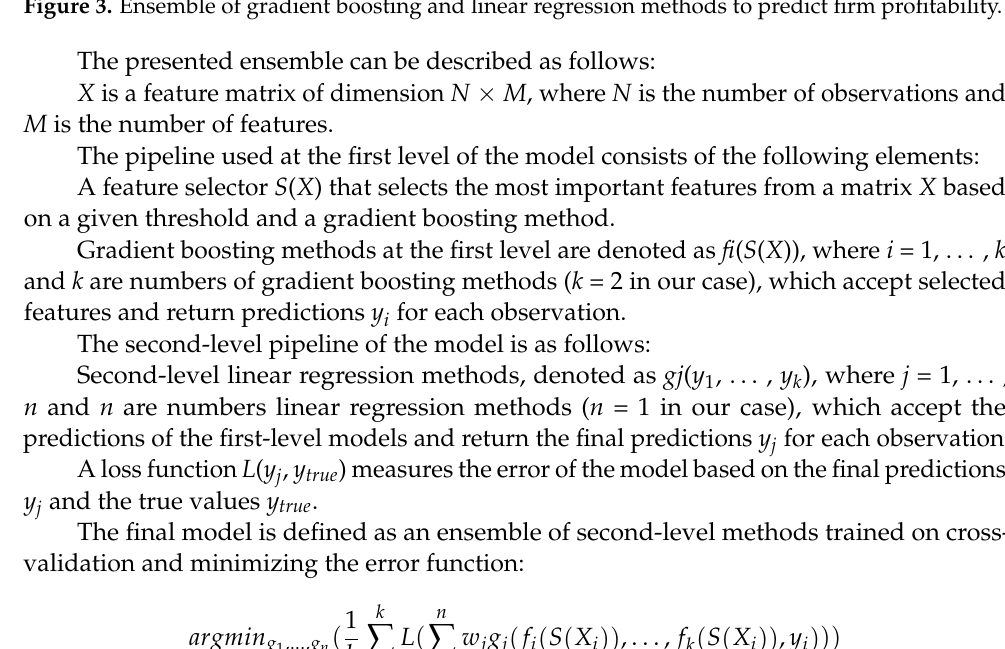
Figure 3. Ensemble of gradient boosting and linear regression methods to predict firm